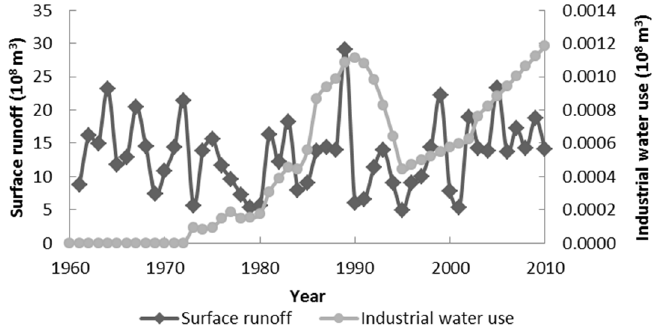
Figure 9. Total surface runoff and industrial water consumption in the Qinghai Lake catchment.